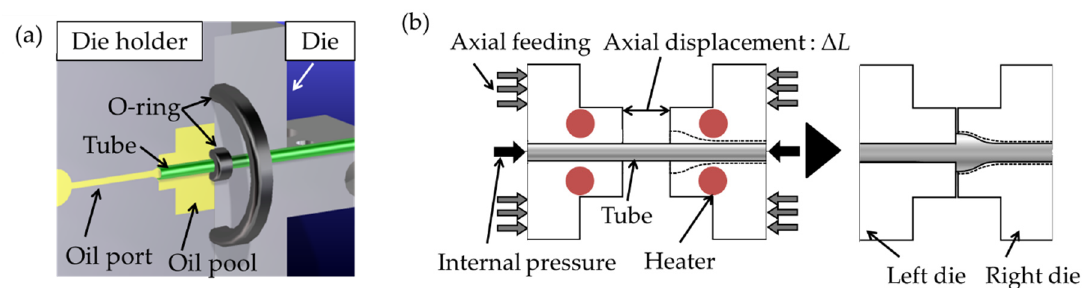
Figure 3. Geometry diagram of the die for the warm tube hydroforming (THF): ( a ) sealing mechanism; ( b ) loading mechanisms of the axial feeding and internal oil pressure in the tube for the